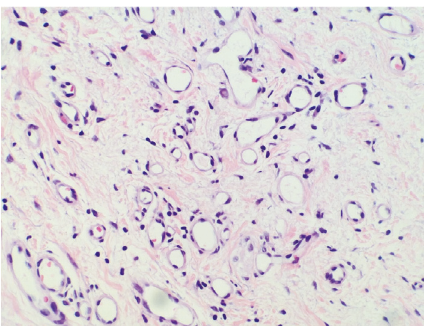
Figure 5: Cystic spaces lined by bland flattened epithelial cells with surrounding fibromuscular